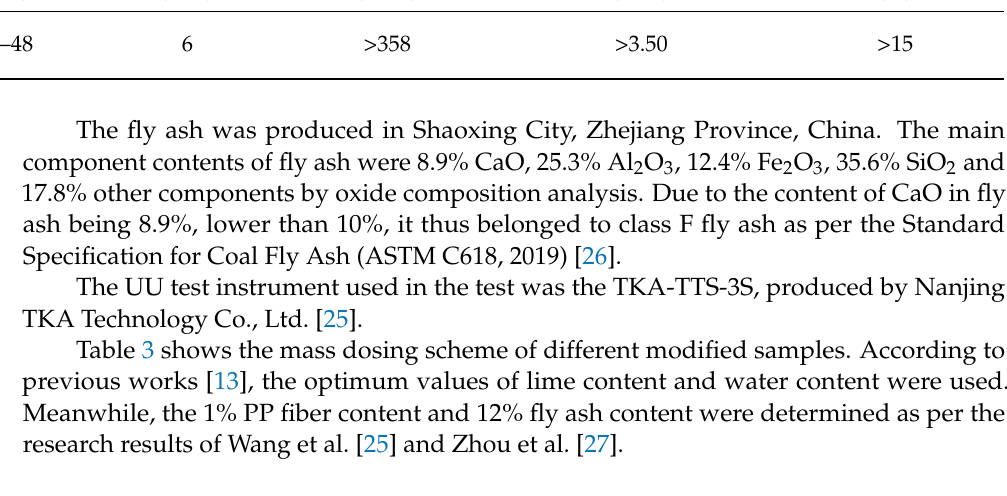
Table 3. Mass dosing scheme of different